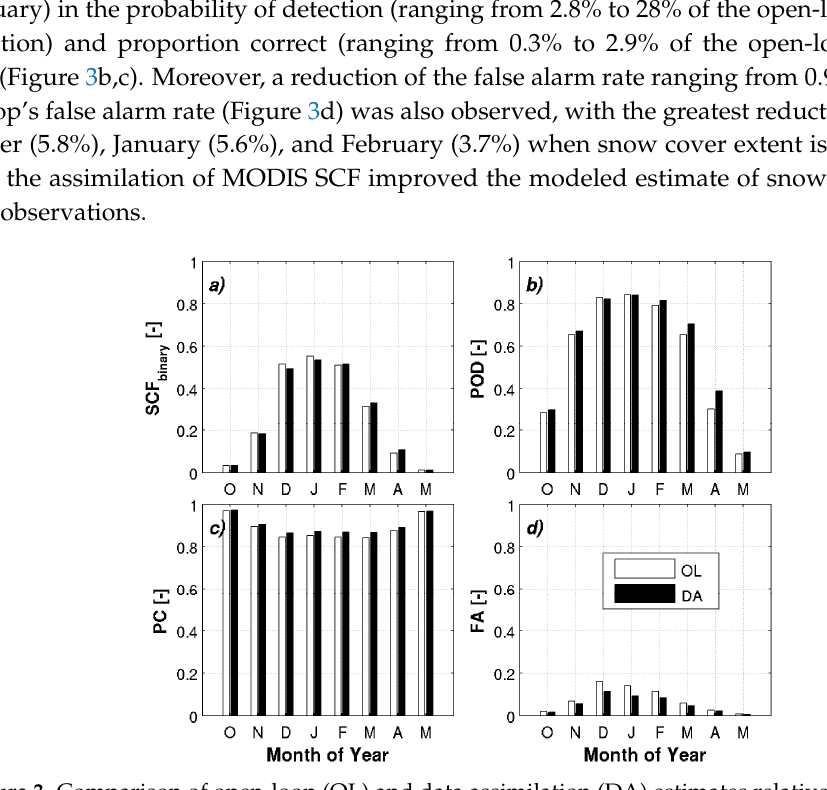
Figure 3. Comparison of open-loop (OL) and data assimilation (DA) estimates relative to IMS snow cover extent across the conterminous US north of 35 degrees latitude for October 2001 to October 2009 where ( a ) represents the average binary SCF ( (cid:1845)(cid:1829)(cid:1832) (cid:3029)(cid:3036)(cid:3041)(cid:3028)(cid:3045)(cid:3052) ); and ( b ) the probability of detection (POD); ( c ) proportion correct (PC); and ( d ) the false alarm rate (FA).